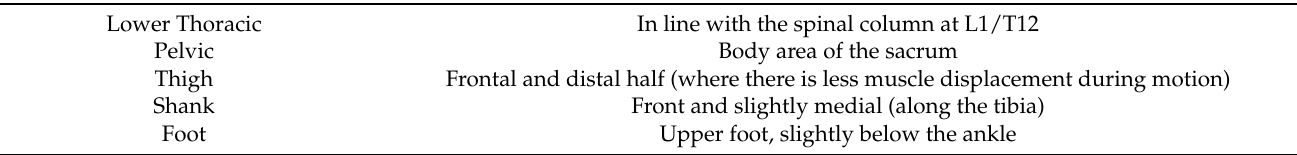
Table 2. Sensor locations.